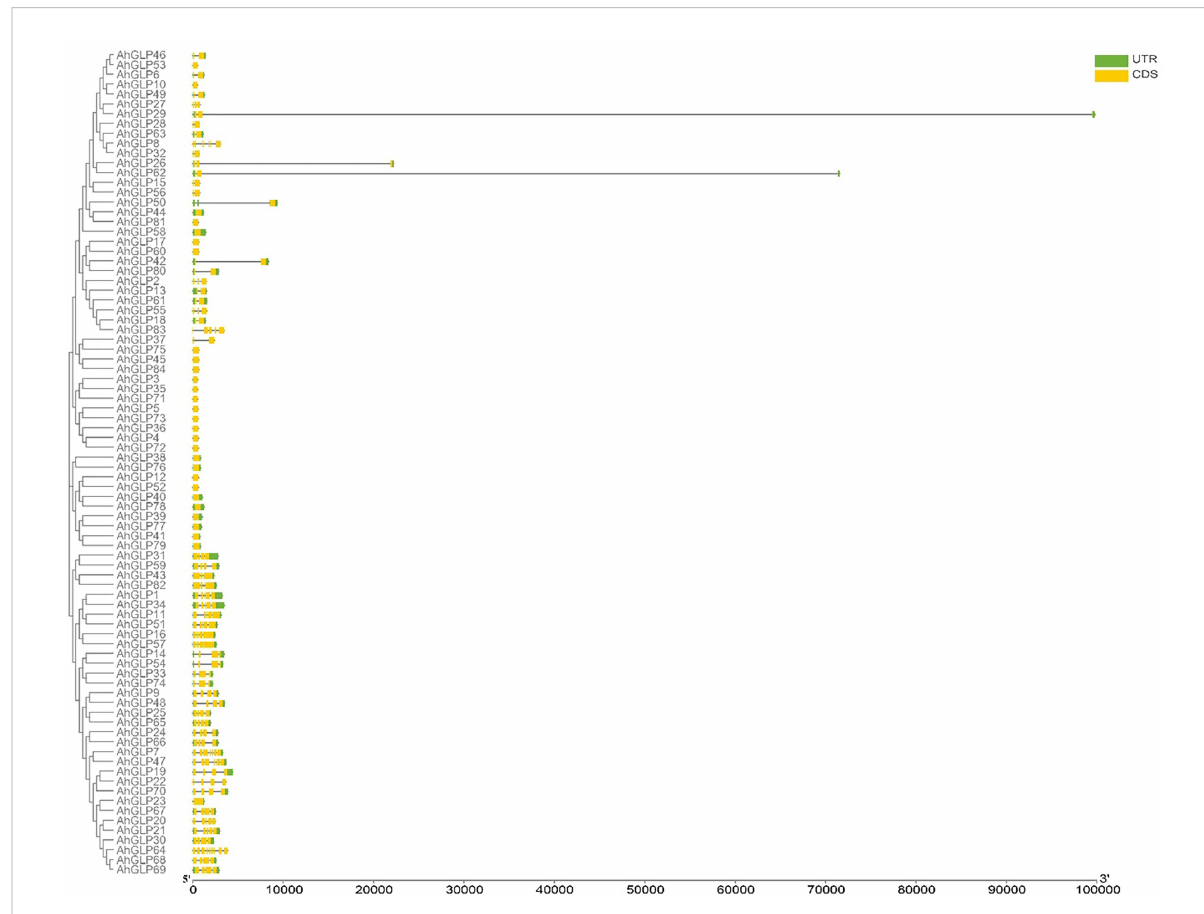
FIGURE 2 Gene structure (exons-introns distribution) of Arachis hypogaea Germin-like protein ( AhGLPs ) genes. Most AhGLPs are composed of a single exon, while the maximum number of exons is 10 ( AhGLP64 ). AhAGLP26 , AhGLP29 , and AhGLP62 possessed very large intron